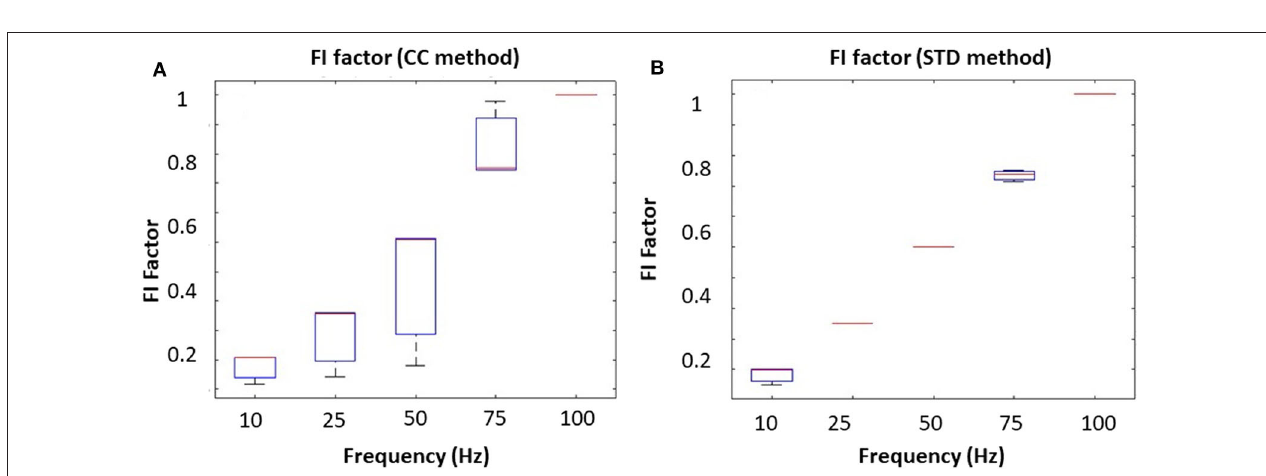
FIGURE 4 | The oscillating frequency corresponding to the FI factor base on different methods: (A) correlation coefficient method and (B) the STD method.